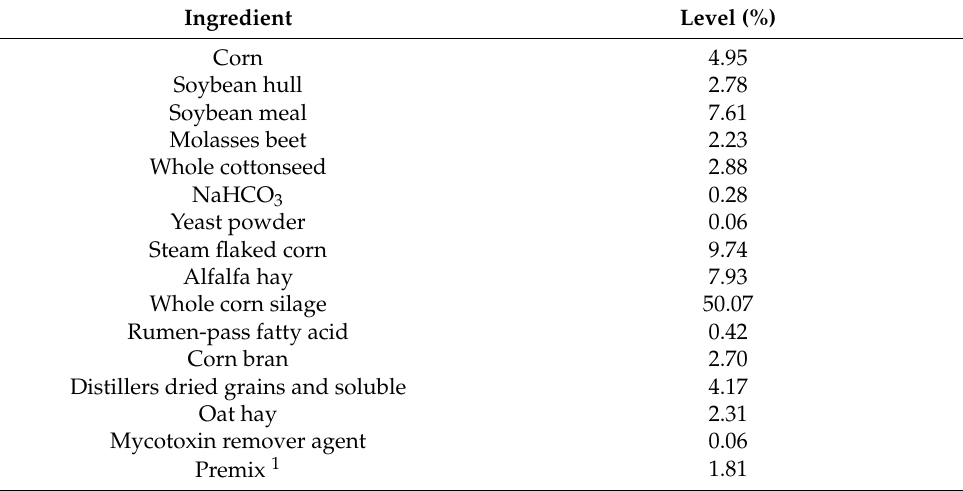
Table 1. Ingredients of total mixed ration used in vitro (dry matter